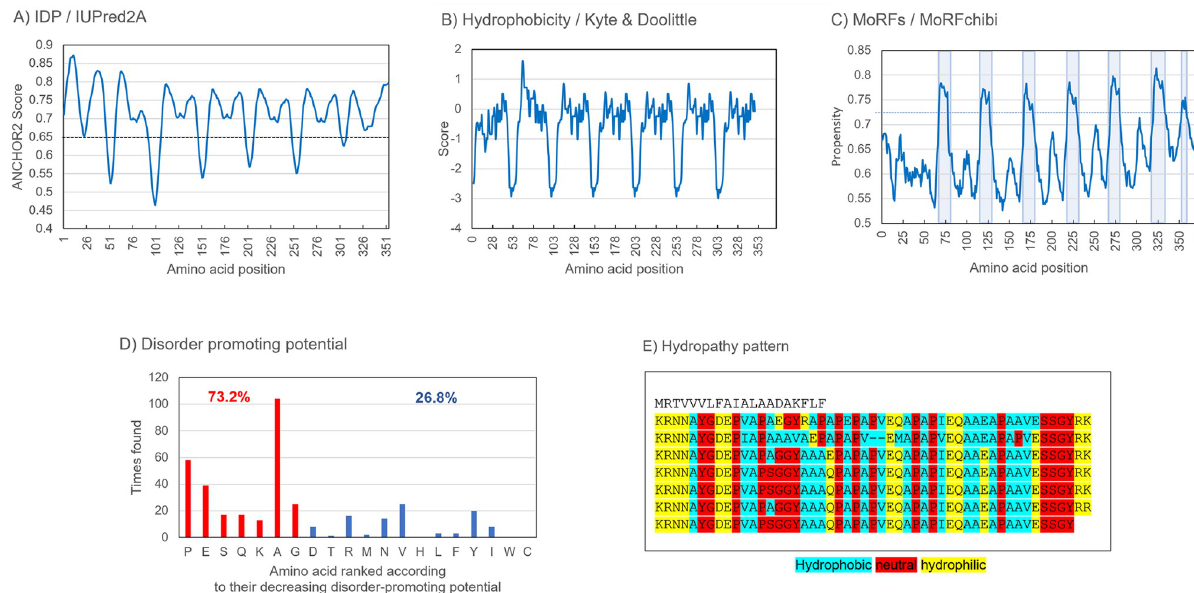
Fig 4. Physicochemical properties of Asu-EPIC-1. A) The protein has a highly intrinsically disordered profile as predicted by IUPred2A [41]. The ANCHOR2 score of 0.65 is a threshold indicative of intrinsically disordered regions. B) Hydrophobicity plot, according to Kyte & Doolittle, shows six hydrophilic regions. C) Identification of seven putative molecular recognition features (MoRFs) (blue regions) using the MoRFchibi SYSTEM [43]. The cut-off level is set at 0.72 (blue line). The first six MoRFs are the parts of the conserved amino acid regions, and each contains two of the three tyrosine residues (SG Y RKKRNNA Y ). The last MoRF is associated with the sequence QAPAPI. D) The distribution and proportion of disorder-promoting amino acids (in red) versus more order-promoting amino acids (blue) [44]. E) Distribution of the hydropathy pattern in the TRs according to Pommie´ et al.